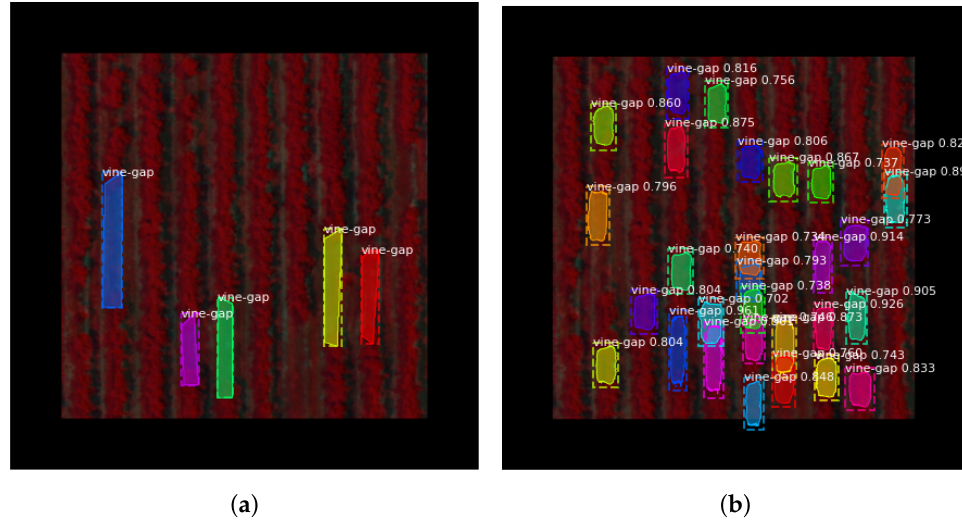
Figure 5. Examples of Mask-RCNN, after training ‘head’ layers for 30 epochs, detecting too many objects. Dataset: CIR; Weights: Tiny-YOLO; ( a ): Original; ( b ): Detected.